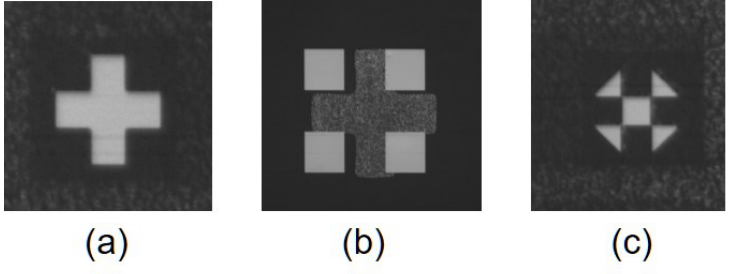
Figure 5. Different shapes of marks: ( a ) represents a cross mark; ( b ) represents a dark cross sand- wiched between four bright squares; ( c ) represents a square surrounded by four triangles. The mark as the key point for calibration and alignment.